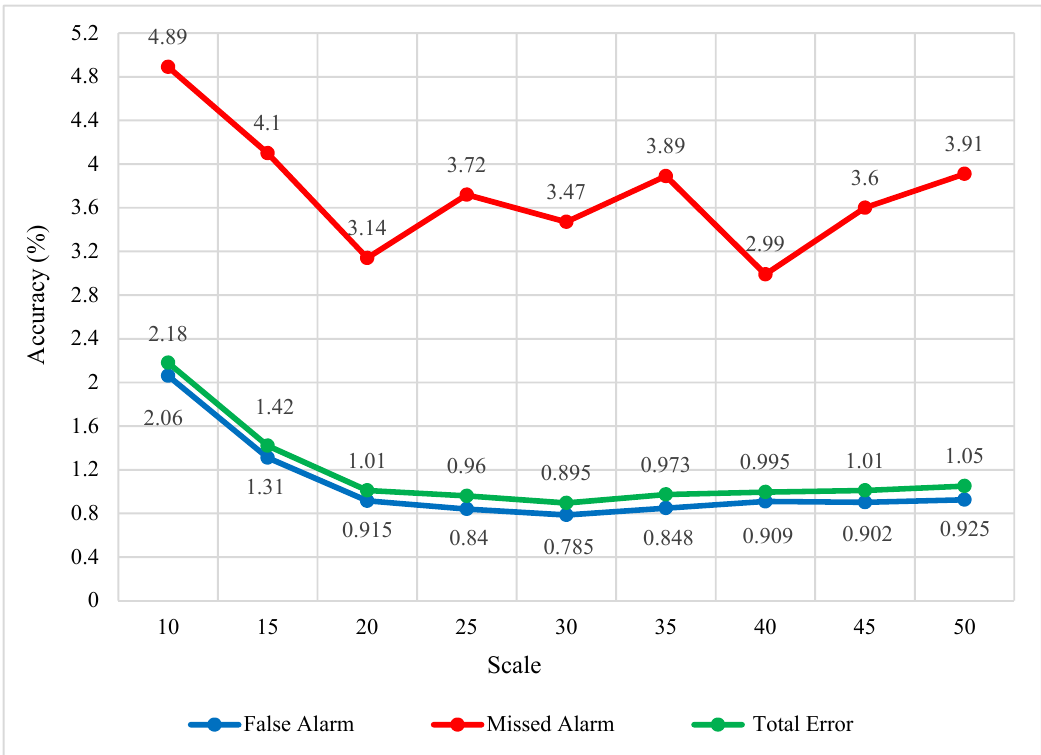
Figure 11. Relationship between the detection accuracies and the scale of the multi-scale segmentation in the proposed approach for the Site B landslide aerial remote sensing images.